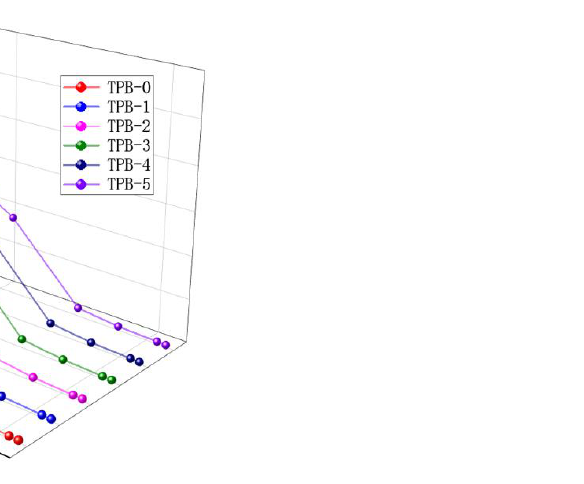
Figure 4. Mass attenuation coefficients ( µ m ) of TPB glass system as a function of the photon energy and the chemical composition.